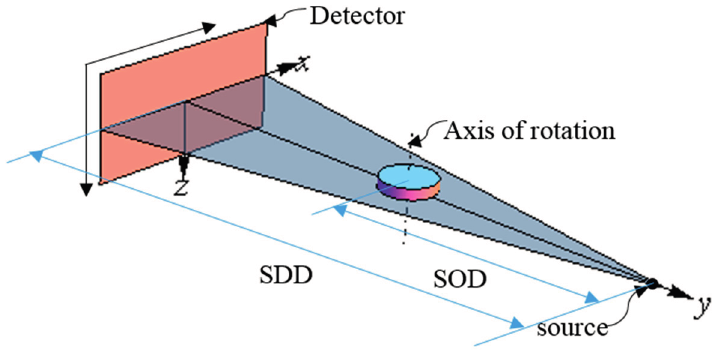
Figure 1. The ideal geometry of a micro-CT